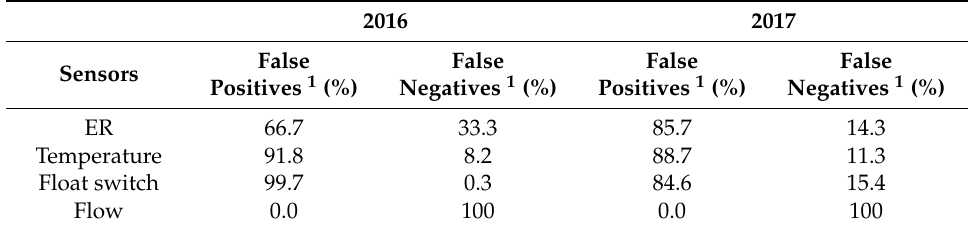
Table 3. Type of errors committed by the sensors for the 2016 and 2017 field